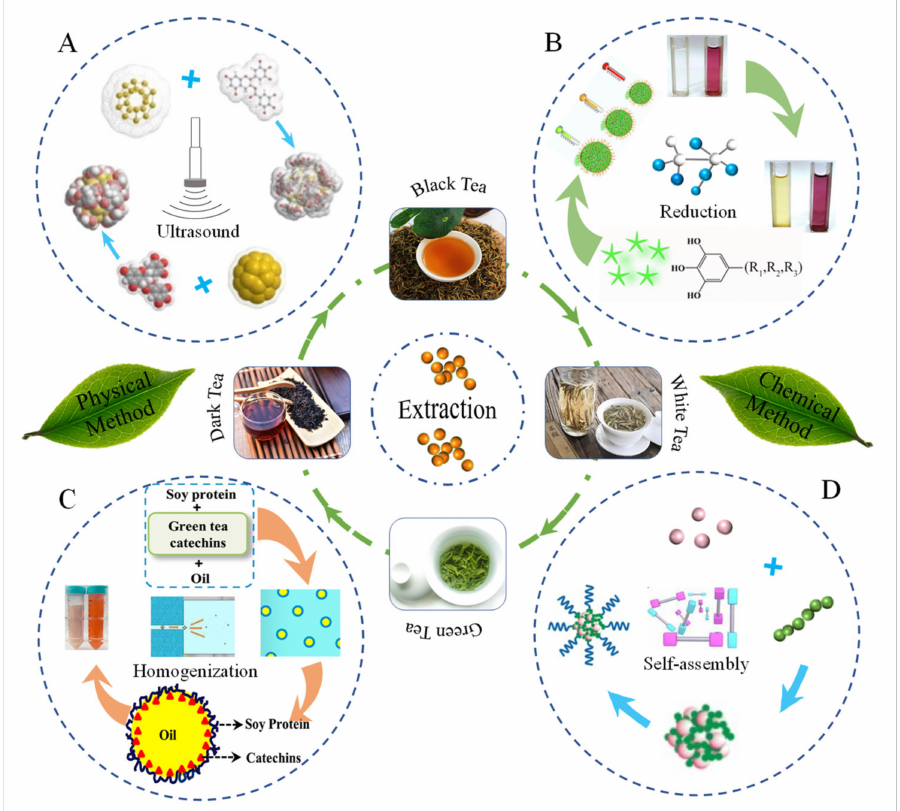
Figure 3. Schematic presentation of nano-encapsulated TPs by ultrasound ( A ), reproduced with permission [44], Copyright © 2011, Elsevier; reduction ( B ), reproduced with permission [47,50], Copyright © 2015, Elsevier; Copyright © 2021, Elsevier; homogenization ( C ), reproduced with permission [51], Copyright © 2018, Elsevier; and self-assembly methods ( D ), reproduced with permission [52], Copyright © 2014, Nature Publishing